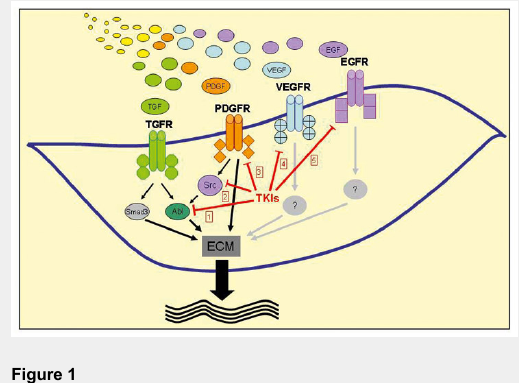
Targeting tyrosine kinases in systemic sclerosis. Transmembrane (TGF-β, PDGF, VEGF, and EGF receptors) as well as intracellular (c-Abl and Src kinases) tyrosine kinases promote the production and release of extracellular matrix (ECM) proteins. Pro-fibrotic downstream signaling of TGF-β and PGDF is well- established and involves Smad proteins, c-Abl, and Src kinases. By contrast, downstream pathways of VEGF and EGF that promote ECM synthesis in SSc fibro-blasts still need in detail characterisation. Regarding their central role in production and release of ECM, tyrosine kinases are promising targets for anti- fibrotic treatment approaches in SSc since they can be blocked by specific inhibitors (TKIs). 1) Imatinib, dasatinib, and nilotinib block the intracellular tyrosine kinase c-Abl, a downstream target of pro- fibrotic TGF-β signaling. 2) In addition to its effects on c-Abl and the PDGF receptor, dasatinib inhibits Src kinases, which link increased PDGF receptor activity with activation of c-Abl. 3) Imatinib, dasatinib, and nilotinib are inhibitors of the PDGF receptor, which can promote ECM production directly or via activation of Src kinases and c-Abl. 4) Semaxinib, vatalanib, sutent, and sorafenib block VEGF receptor signalling and might decrease ECM production. The exact mechanisms linking VEGF receptor signalling and ECM synthesis are still unclear. 5) Erlotinib, gefitinib, lapatinib, and canertinib block EGF receptors. Although downstream pathways of EGF signalling are only partially